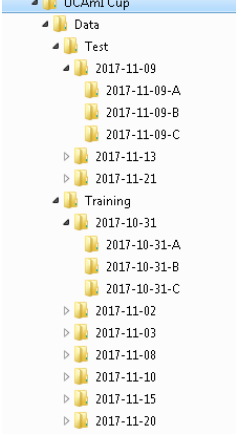
Figure 3. File structure of the data folder.